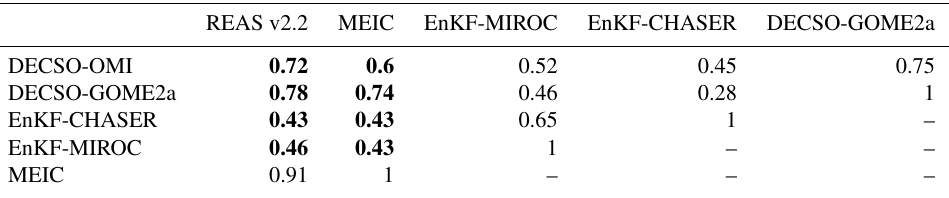
Table 1. Temporal correlation coefficient of the 36 pairs of monthly NO x emissions over mainland China from 2008 to 2010. The bold values indicate the relation between bottom-up and satellite-based inventories.